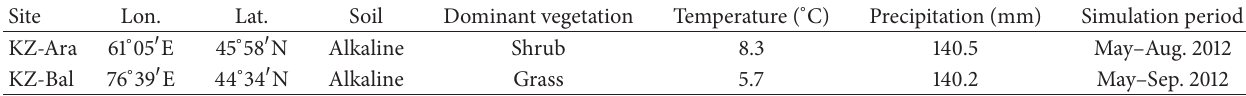
Table 1: Location, soil, vegetation, climate factors, and flux time series at KZ-Ara site and KZ-Bal